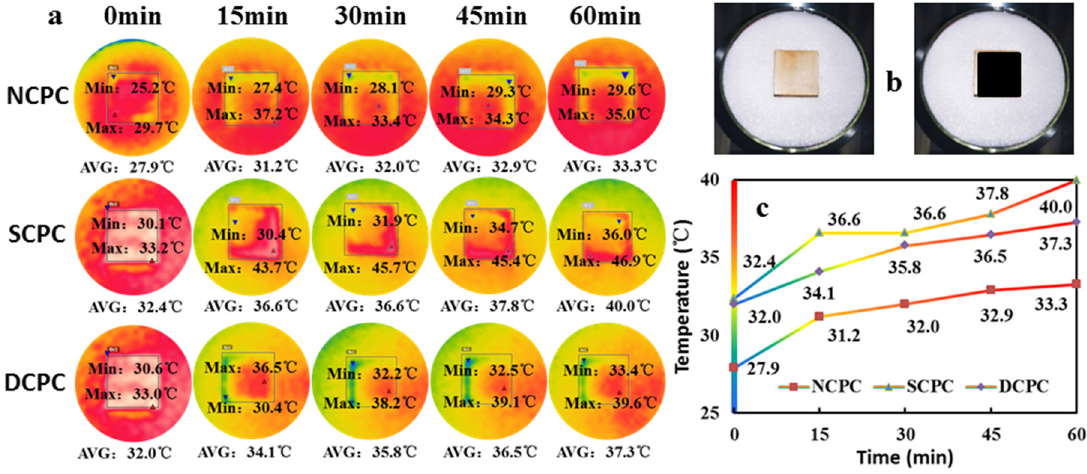
Figure 4. Infrared image of specimen at 1 kW·m –2 simulated solar illuminance. ( a ) Thermal imaging change diagram of specimens; ( b ) installation diagram of specimens; and ( c ) temperature variation diagram of specimens.